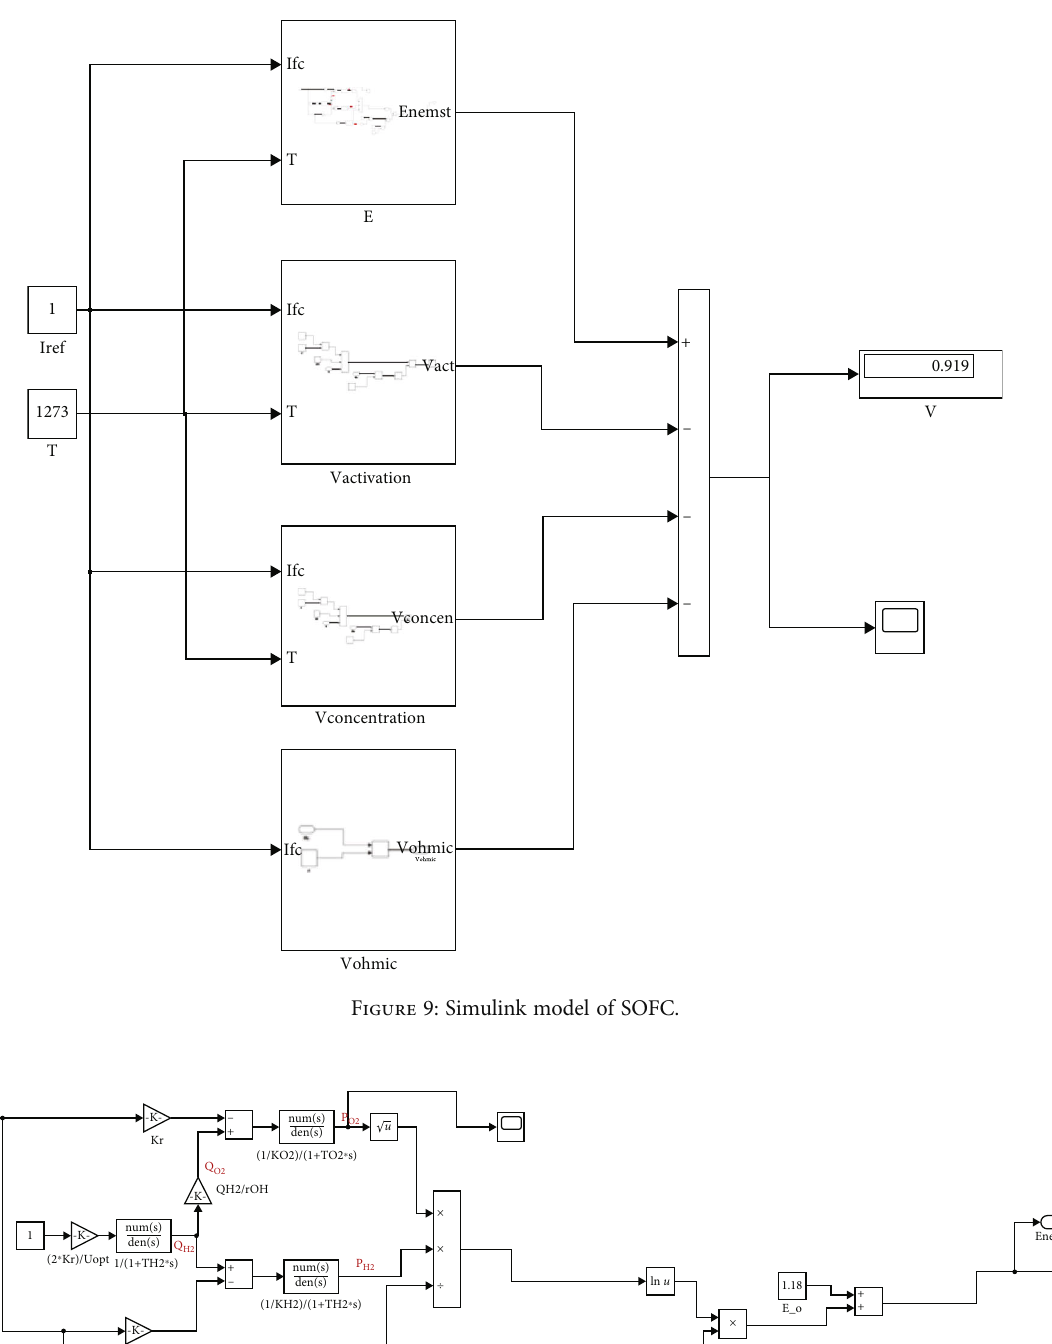
Figure 10: Simulink model for reversible open circuit voltage (E) of